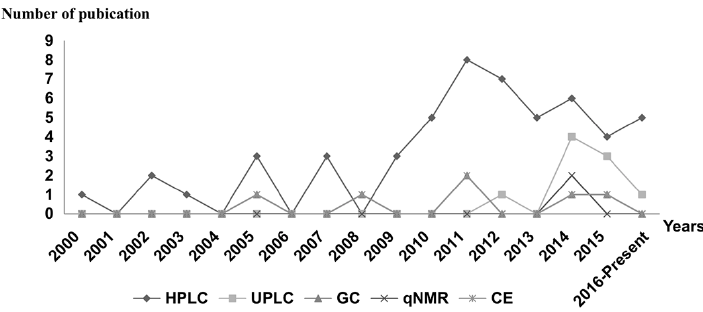
Figure 3. The development trend of the main analysis methods.